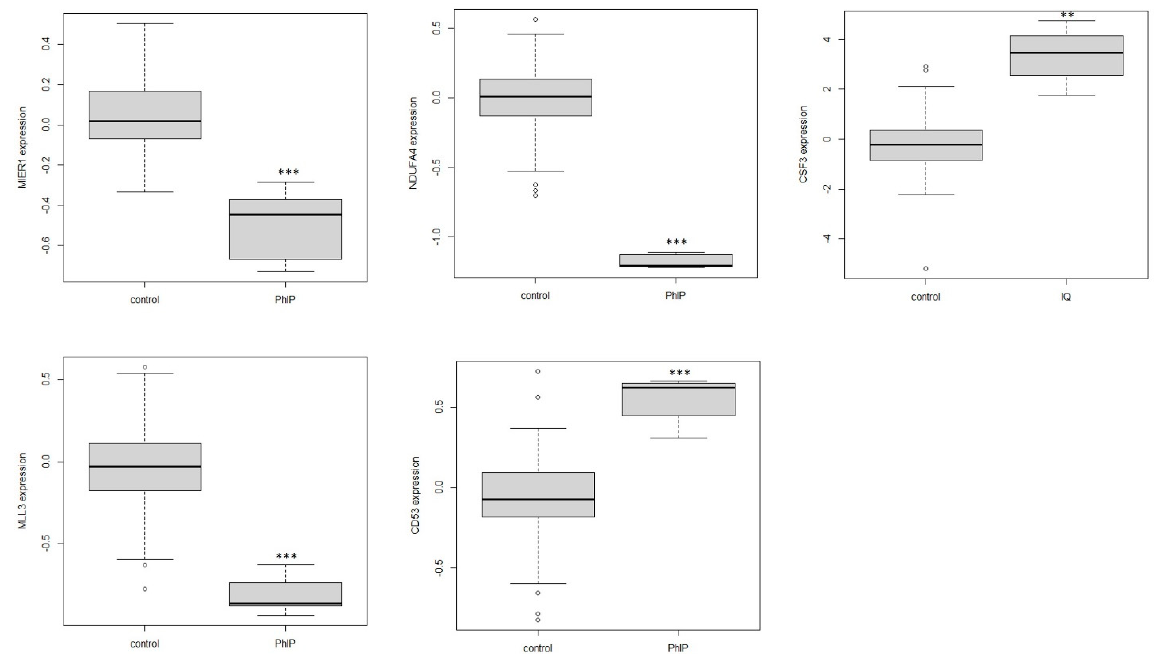
Figure 6. The gene expression of five feature genes between dose and control group. The gene expression values from 84 samples after normalization by LIMMA analysis was used to plot the boxplot; The value of genes in PhIP or IQ samples were the dose group and the other 79 samples served as the control. A Wilcoxon test was employed to compare the difference between the dose group and the control, with ** p -value < 0.01 and *** p -value < 0.001.